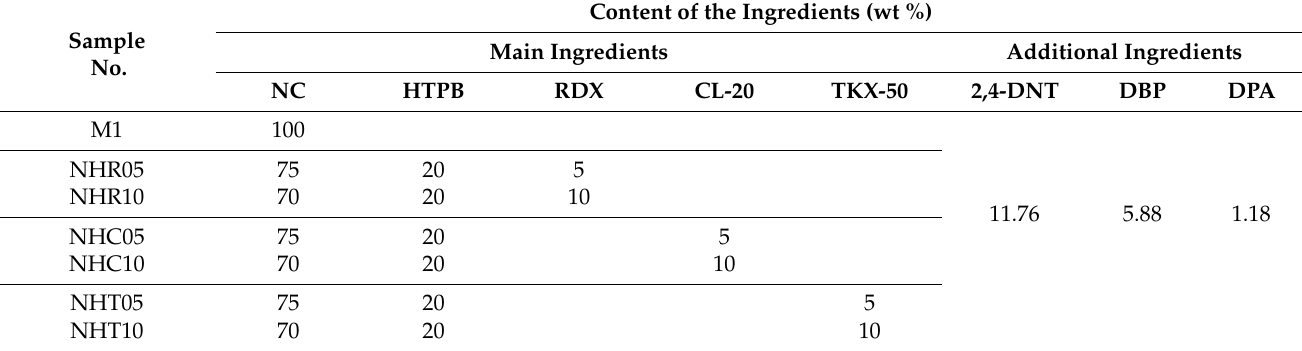
Table 1. Compositions of test samples.